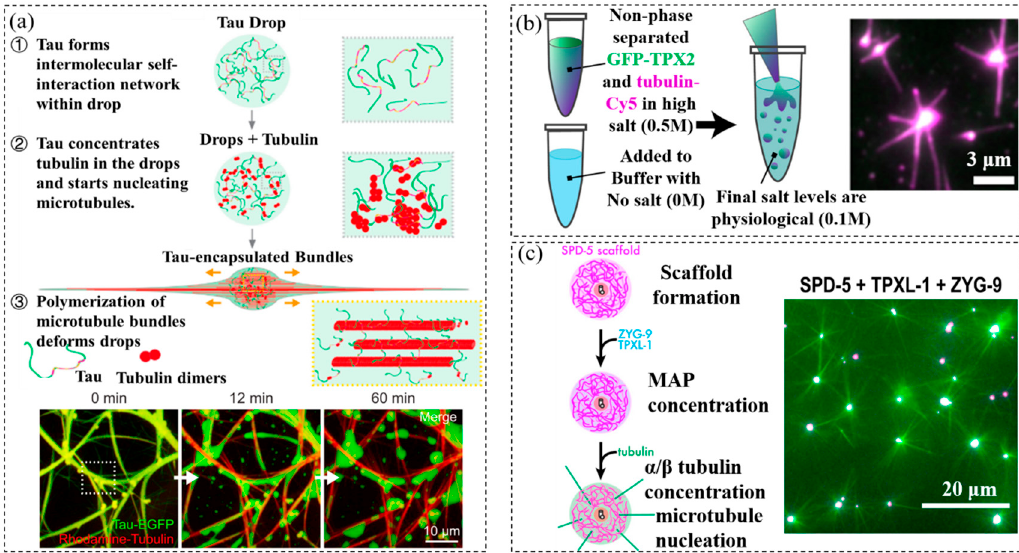
Figure 3. ( a ) Tubulin polymerization inside Tau droplets. Reprinted with permission from Ref. [41] 2018, Elsevier. ( b ) Tubulins nucleation inside TPX2 droplets to allow the formation of